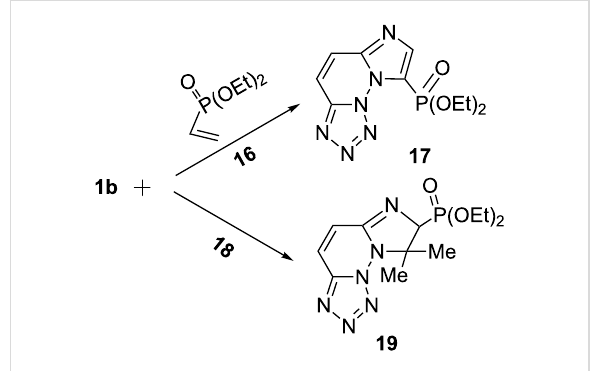
Scheme 6: Synthesis of fused imidazophosphono-substituted com- pounds 17 and 19 .